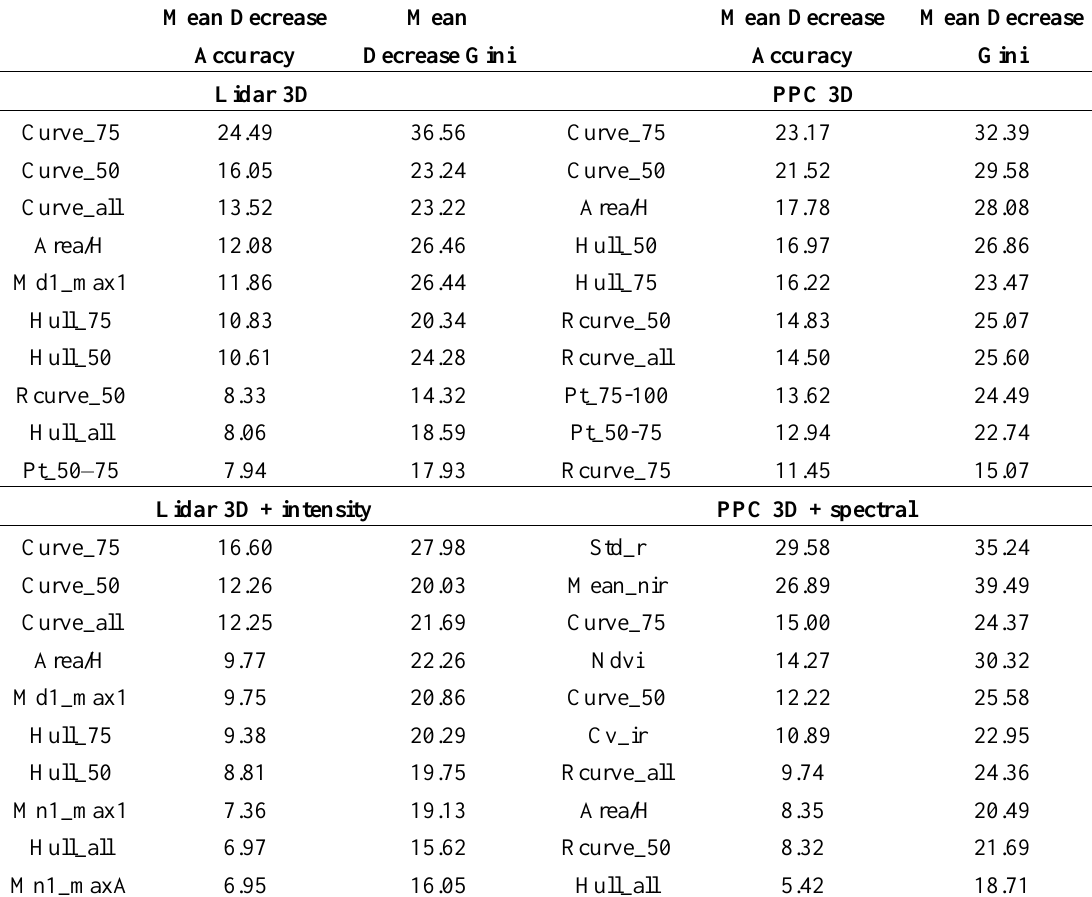
Table 8. Mean decrease in accuracy, and mean decrease of the Gini index associated to the metrics for each of the